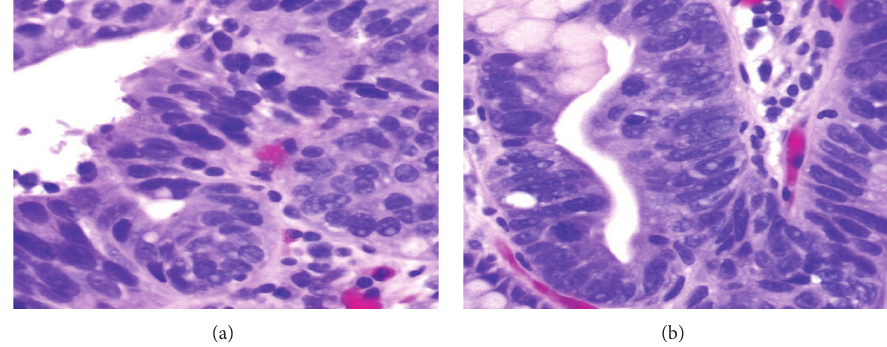
Figure 4: (a) GE junction mucosa with focal intestinal metaplasia and extensive high grade dysplasia/adenocarcinoma in situ . (b) High grade dysplasia extends to one margin and detached fragments of high grade dysplasia are also present.